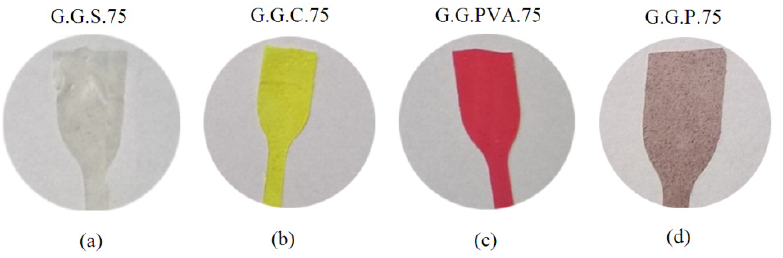
Figure 2. Pictures of compositions with fillers: G.G.S.75 ( a ); G.G.C.75 ( b ); G.G.PVA.75 ( c );